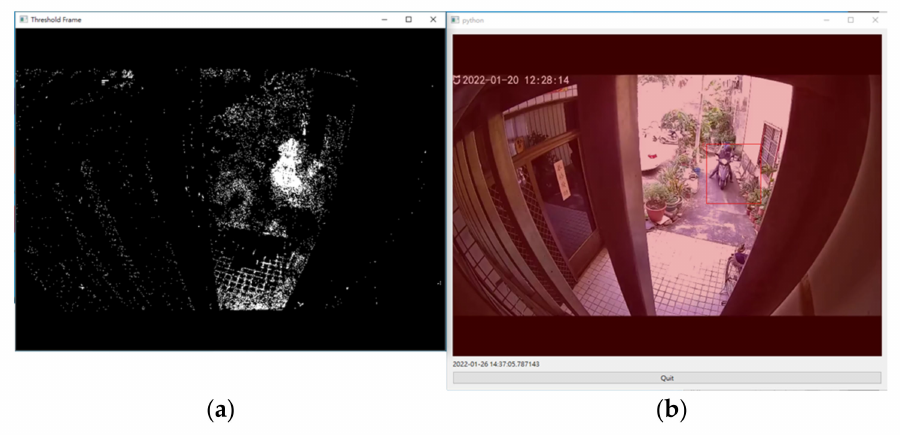
Figure 6. The custom 6 persons’ dataset captured by a home camera: ( a ) frame difference result and ( b ) motion detection